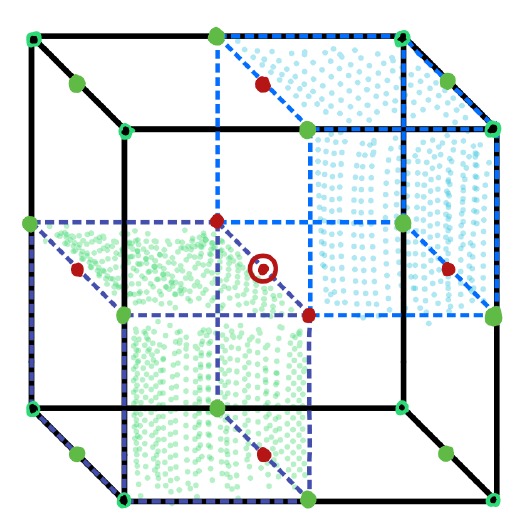
Figure 7: Calculation using double cover of SO ( 6 ) : the figure depicts saddles on ( ˜ ω ) 3 − space. The center of the cube is at ( 0,0 ) , marked red and circled. , ˜ ω , ˜ ω 1 2 3 ) where a = ± 1. For the bosonic case, all the saddles The 8 corners are at ( a , a , a i 1 2 3 contribute. When we add fermions in the mix, the green colored saddles at the middle point of edges (corresponding to 1 dimensional object edge) and green / black colored saddles at the corners (corresponding to 3 dimensional object cube) don’t contribute anymore, leading to a factor of 1 / 2. The saddles corresponding to the zero dimensional center and midpoints of the faces (2 dimensional object) always contribute. Fluctuation around the saddles corresponding to k dimensional object contributes 2 k − 3 compared to that of the center